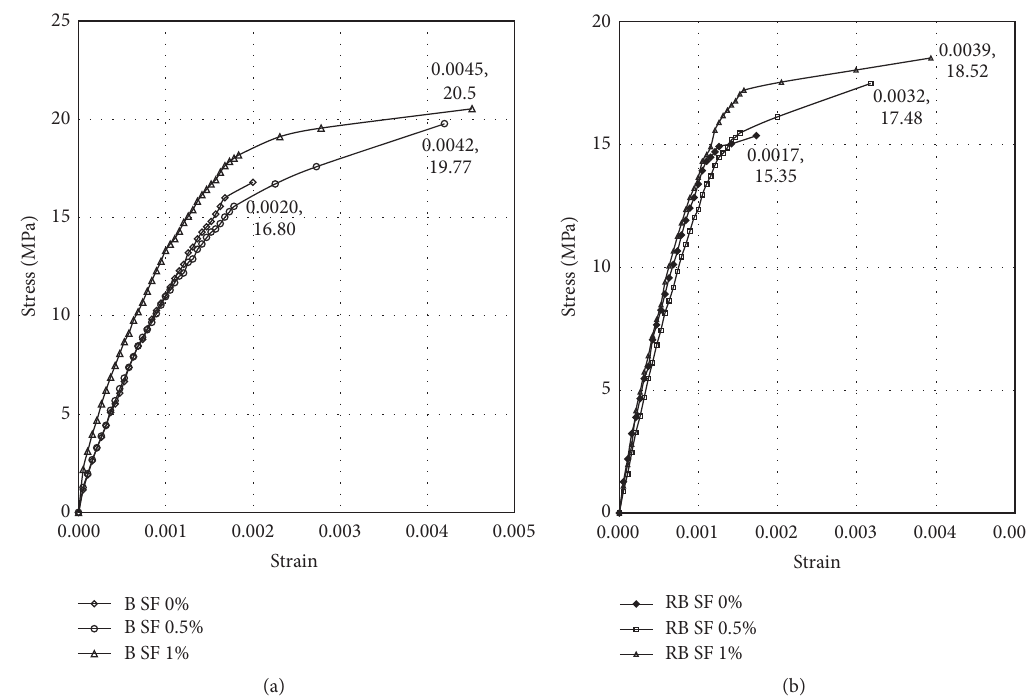
Figure 12: Stress-strain diagram at 14 day; (a) B aggregate and (b) RB aggregate.